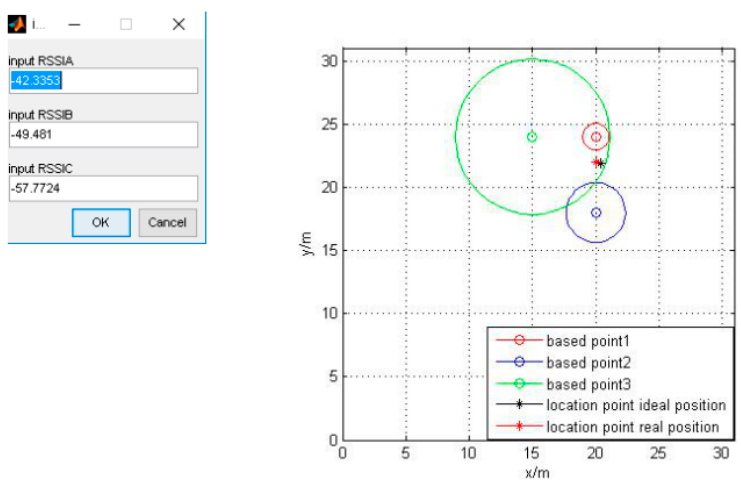
Figure 9. Simulation result when the RSSI values are − 42.3353, − 49.481, and − 57.7724 (dBm) for the three points (a, b, and c).